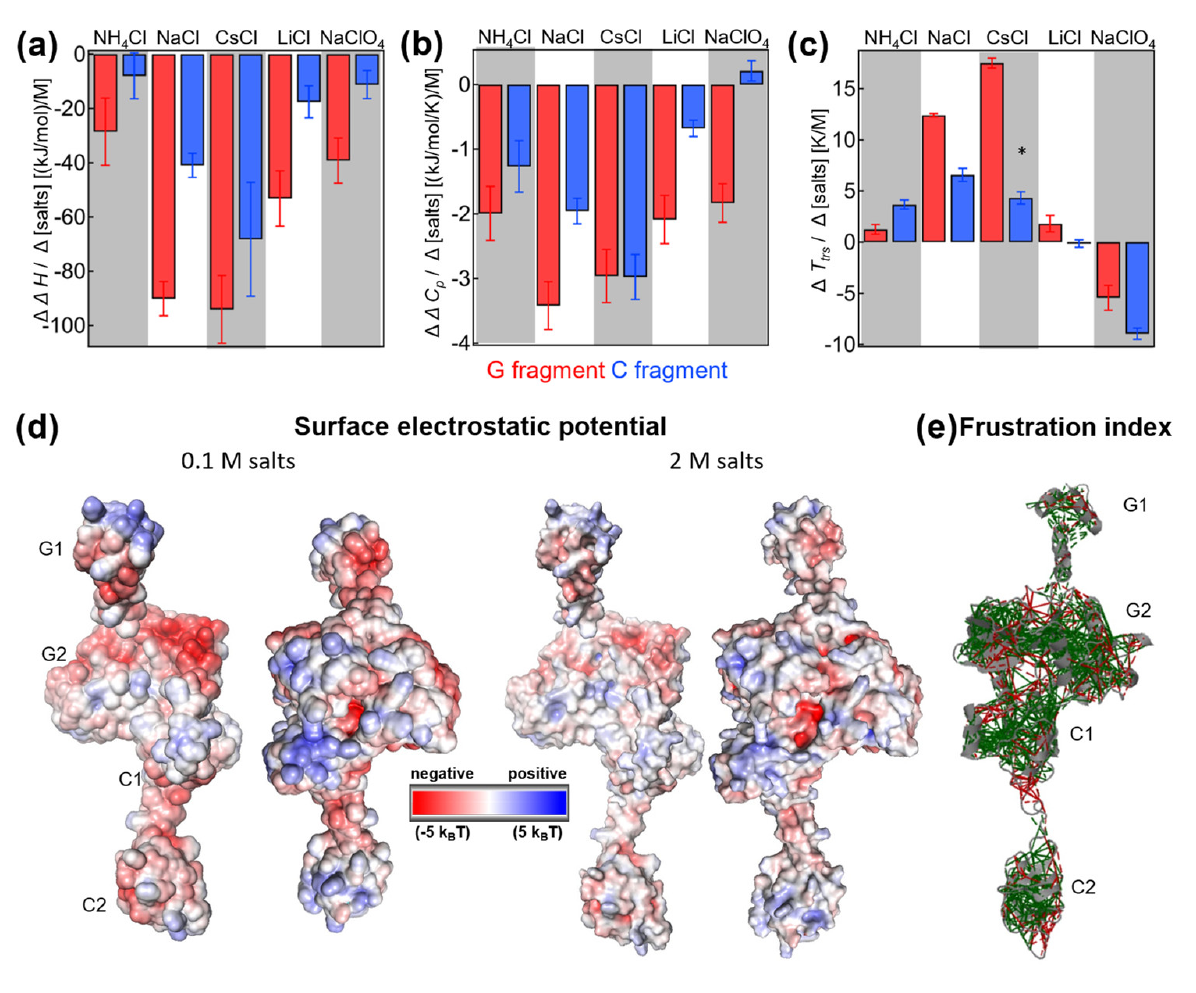
Figure 5. The salt-concentration-dependent changes in enthalpy ( a ), heat capacity ( b ), and temper- ature of transition ( c ) for the G fragment (red) and C fragment (blue). ( d ) Distribution of surface electrostatic potential in the presence of 0.1 M salt (left) and 2 M salt (right). ( e ) The frustration index analysis performed by [43−45]. The color of the lines indicates whether a given contact is minimally (green) or highly (red) frustrated. The energy of a contact between two amino acids in a protein determines how favorable that interaction is. A contact is considered “minimally frustrated” if its energy is on the lower end of the possible range of energies for that type of contact. Conversely, a contact is considered “highly frustrated” if its energy is on the higher end of the range. For more details, please see the Discussion and Materials and Methods sections. Significant correlations and linear dependencies (≤5% probability, yellow background in Table S1) are shown as stars (*).